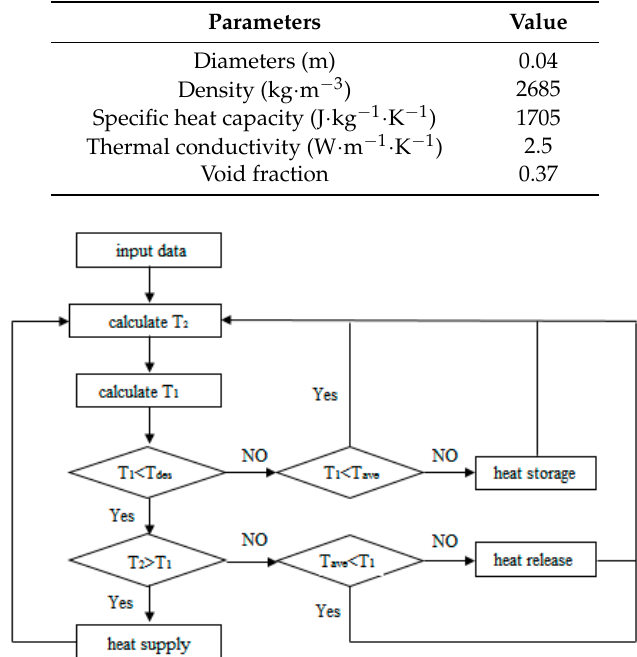
Table 3. Physical parameters of the pebble bed used in the simulated cases.